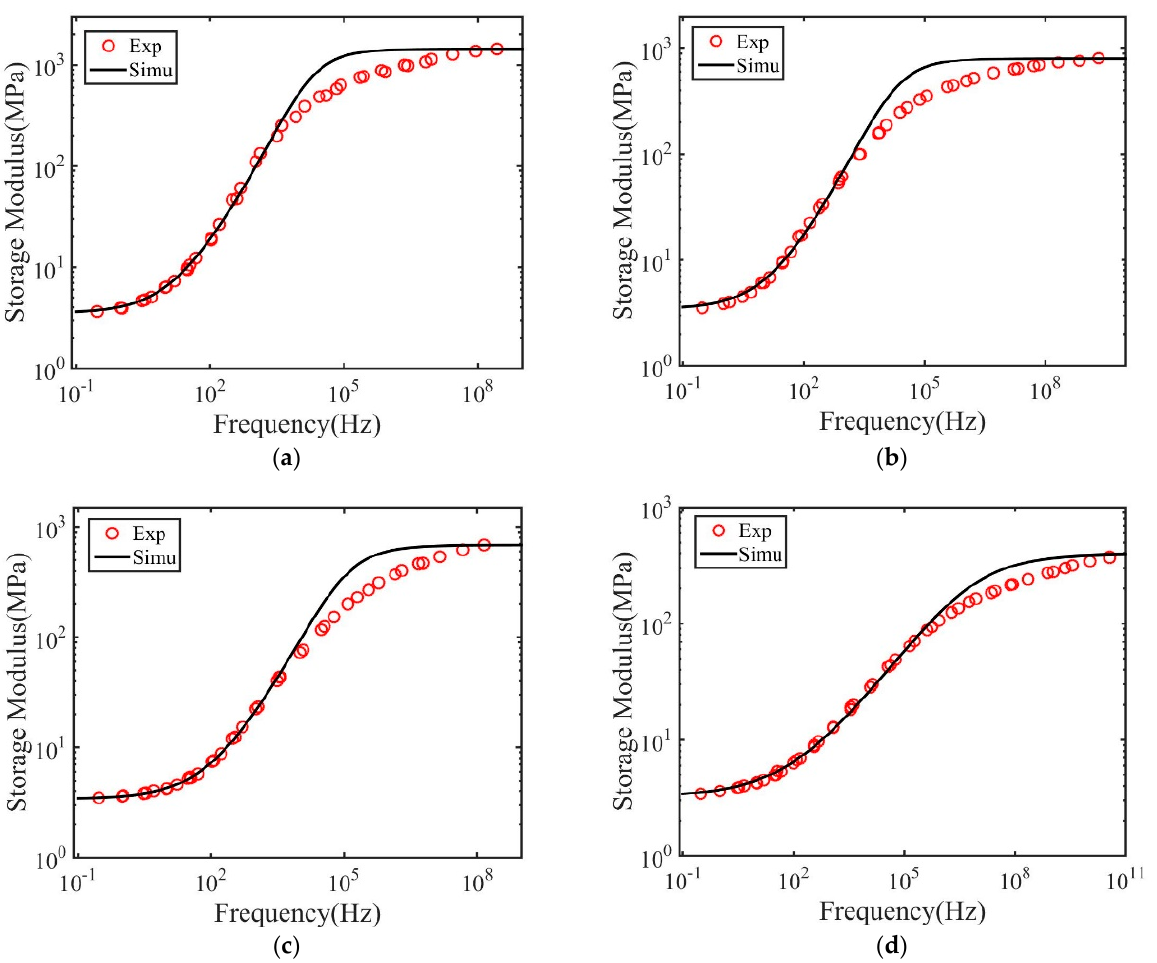
Figure 10. Measured and fitted master curve for polymers with 20 wt.% crosslink density and subjected to ( a ) 0 h, ( b ) 1 h, ( c ) 2 h and ( d ) 10 h immersion time in IPA.